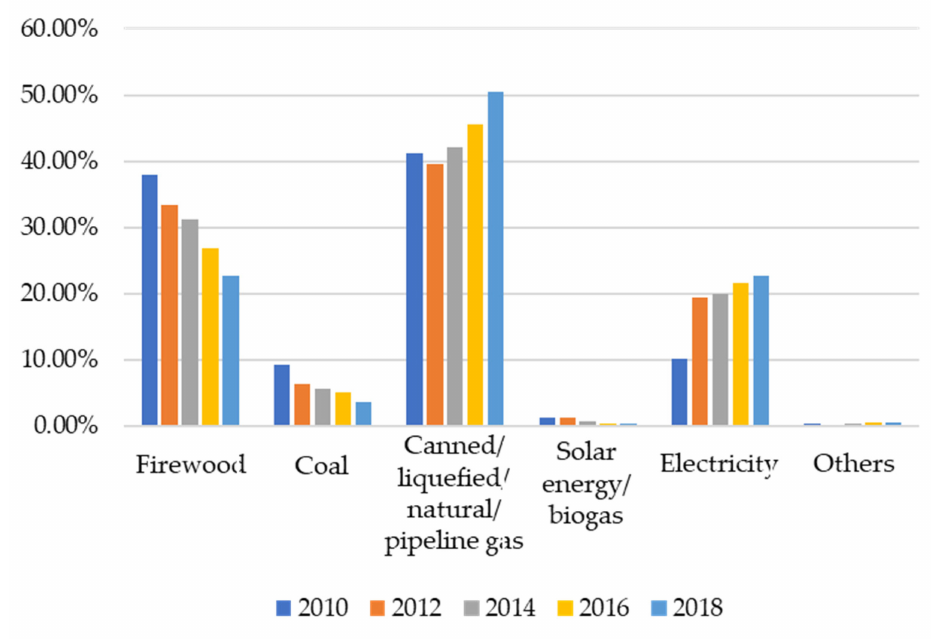
Figure 1. Changes in the proportion of household main cooking fuels from 2010 to